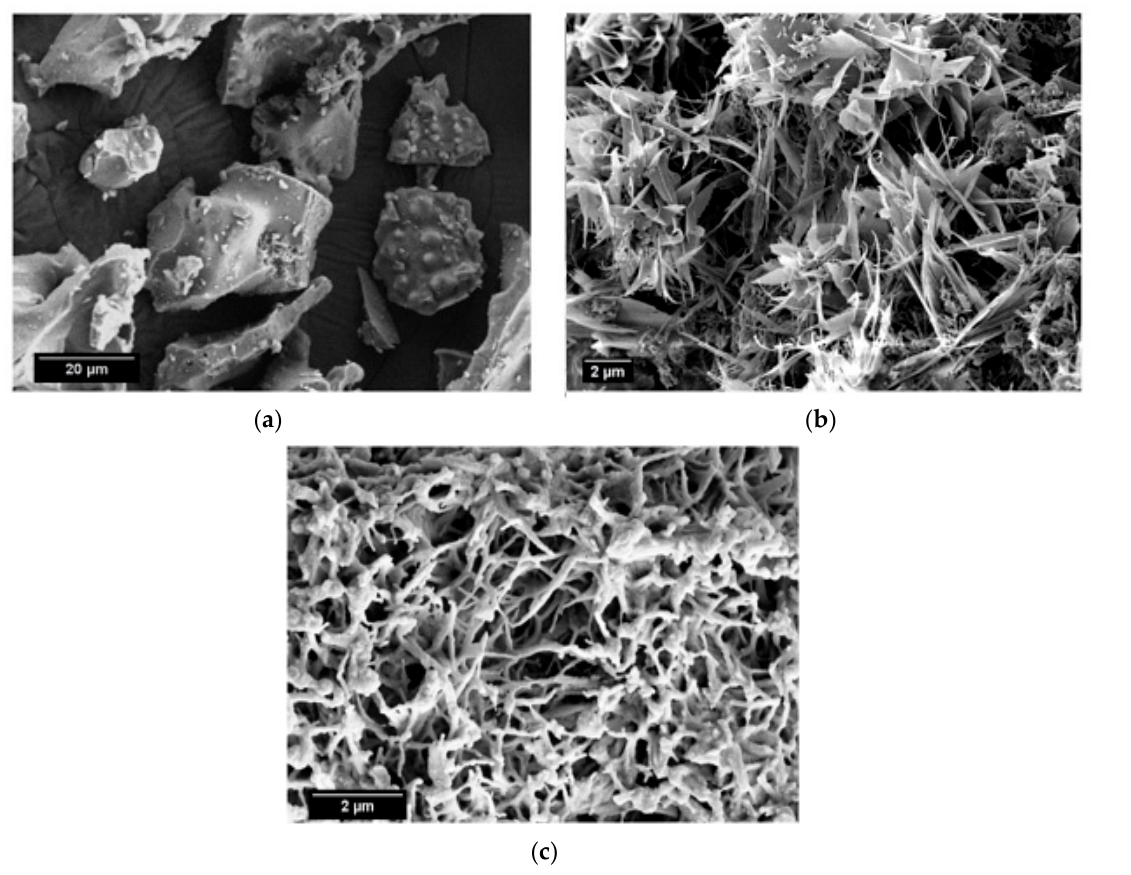
Figure 2. SEM micrographs of ( a ) rice husk ash; ( b ) calcined limestone; and ( c ) β -wollastonite.